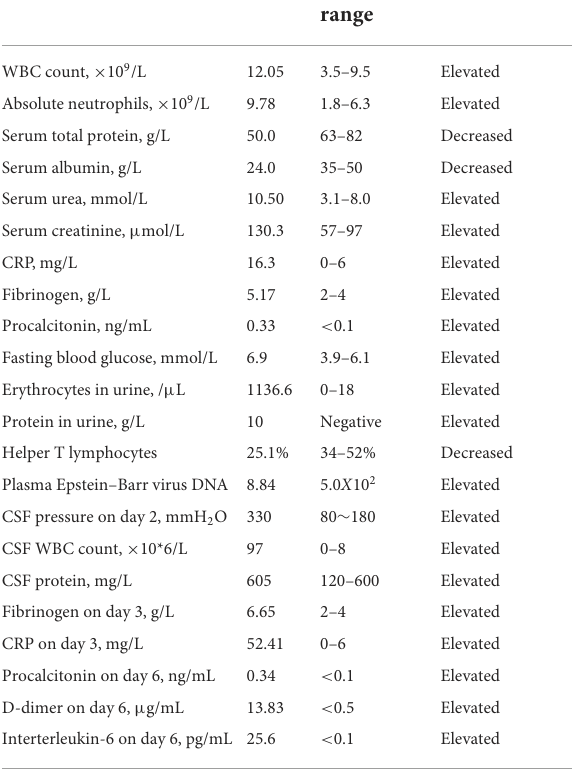
TABLE 1 Laboratory